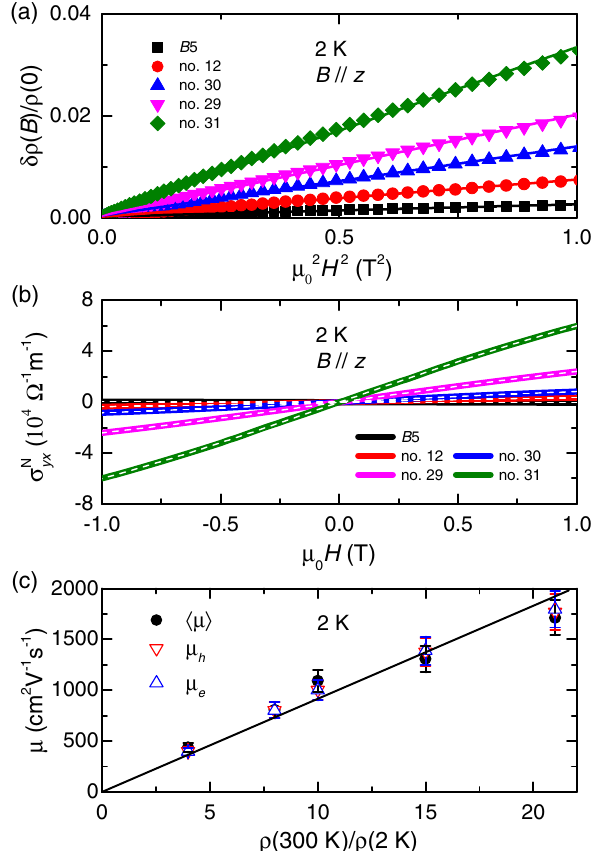
FIG. 2. Quantifying mobility. (a) Low-field magnetoresistance in five different samples as a function of B 2 (T 2 ), where δρ ð B Þ ¼ ρ ð B Þ − ρ ð 0 Þ . As expected, magnetoresistance is quad- ratic in field and is larger in cleaner samples. (b) Low-field ordinary Hall conductivity. Dashed lines show fits to a two-band model. (c) Mobility of electrons and holes (extracted from Hall conductivity), the average mobility (extracted from magneto- resistance) as a function of RRR of each sample. They scatter around solid line with zero